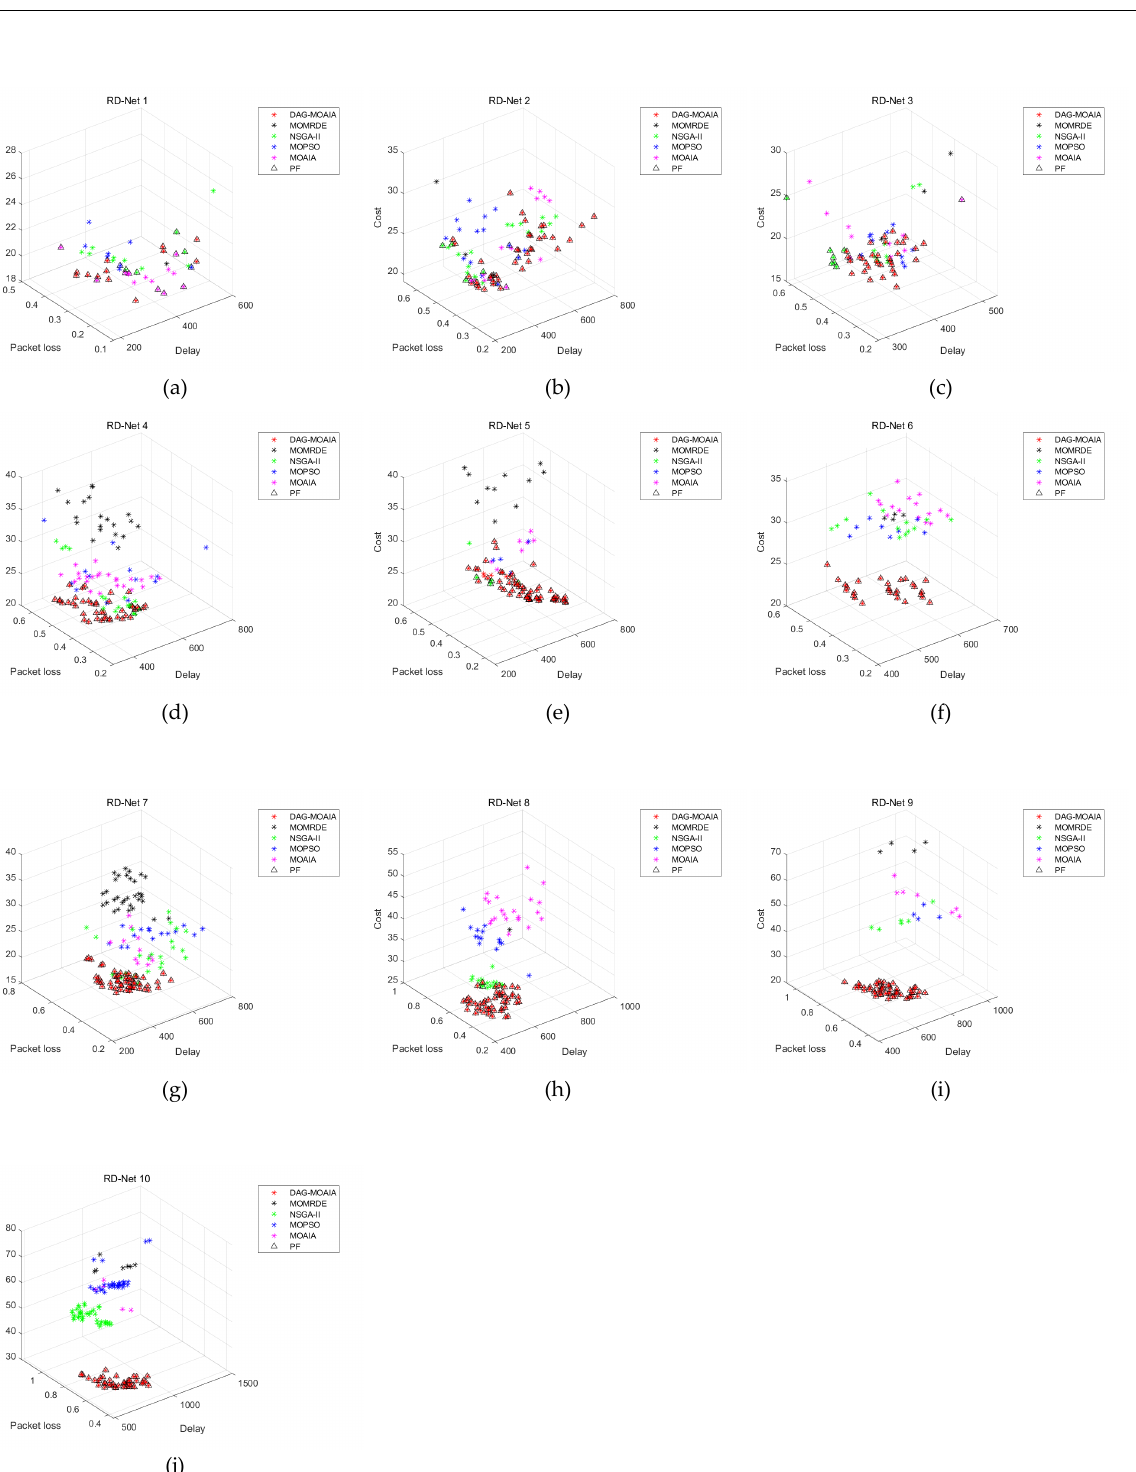
Figure 8. The comparison of Pareto front in three dimensions. ( a ) The comparison of the Pareto front in the RD_Net 1. ( b ) The comparison of the Pareto front in the RD_Net 2. ( c ) The comparison of the Pareto front in the RD_Net 3. ( d ) The comparison of the Pareto front in the RD_Net 4. ( e ) The comparison of the Pareto front in the RD_Net 5. ( f ) The comparison of the Pareto front in the RD_Net 6. ( g ) The comparison of the Pareto front in the RD_Net 7. ( h ) The comparison of the Pareto front in the RD_Net 8. ( i ) The comparison of the Pareto front in the RD_Net 9. ( j ) The comparison of the Pareto front in the RD_Net